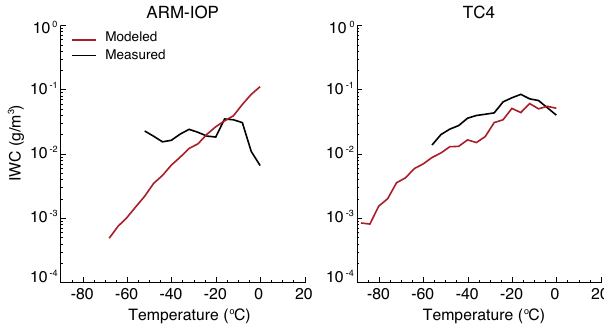
Figure 6. IWC from model (red) and observations